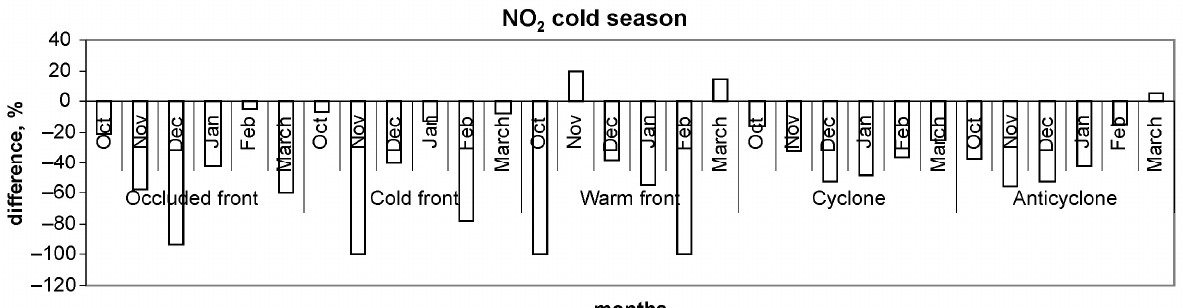
Fig 5. Difference between SO 2 three-year monthly average and average concentration during warm season at Preila background station